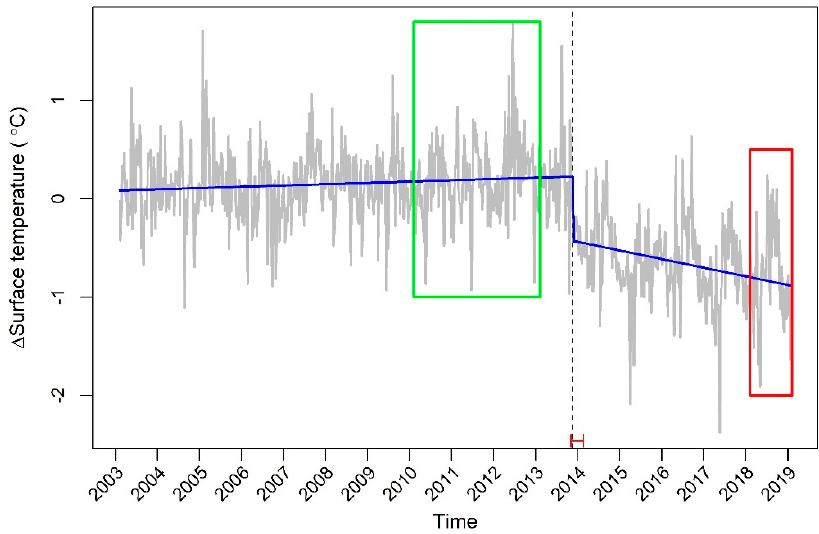
Figure 1. The time series (gray line) of the difference between the surface temperature in PV powerplant and the surface temperature in control region (surface temperature in PV powerplant minus surface temperature in control region, term as ∆ surface temperature) during daytime from Zhongwei, China (105.03 ° E, 37.56 ° N), with 8-day data (gray line), trend (blue line), and abrupt change time (the dash vertical line) from 2003 to 2018. The PV temperature effect before the installation of the PV powerplants was calculated from the three years (one year starting with January and end with December) average surface temperature (green rectangle) before the abrupt change time and the PV temperature effect after installation of PV powerplants were calculated from the 2018-year average surface temperature.